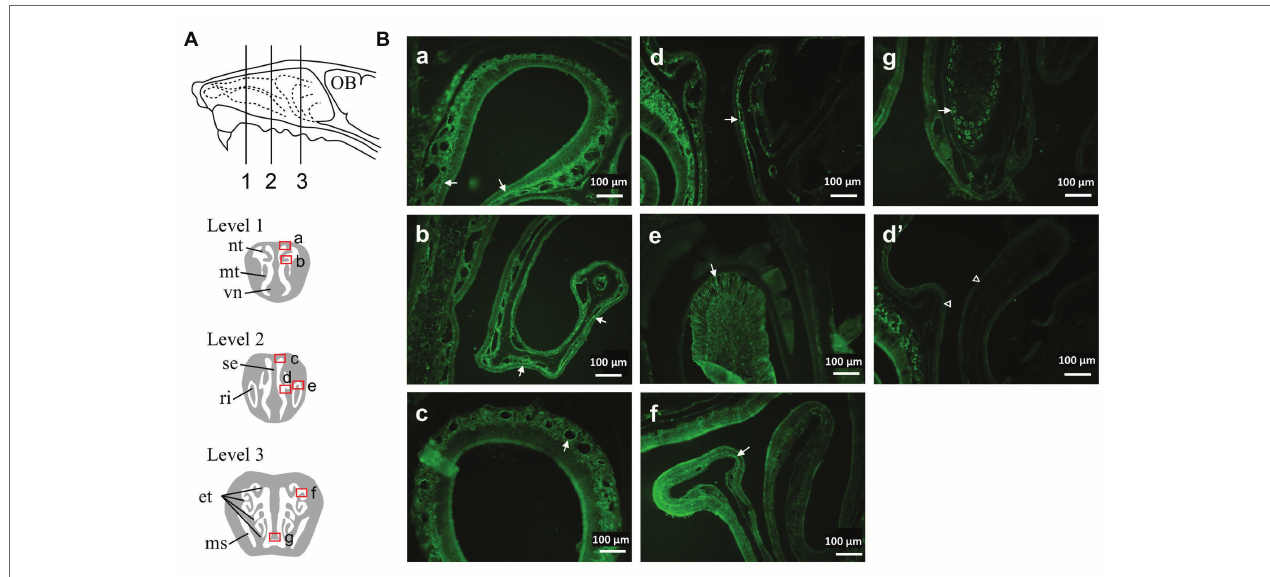
FIGURE 1 | Distribution of Transient receptor potential ankyrin 1 (TRPA1) immunoreactivity in the nasal cavity of mouse. (A) Schematic representation of the lateral view of the mouse nasal area showing three levels of the coronal sections examined. (B) Photomicrographs taken from the areas indicated by squares (a–g) in (A) of a representative mouse. Arrows indicate TRPA1-positive structures (see text). (d’) was taken from a similar region to (d) and treated with a mixture of anti-TRPA1 antibody and an excess amount of antigen peptide. Similar results were obtained in three animals. et, ethmoturbinate; ms, maxillary sinus; mt, maxilloturbinate; nt, nasoturbinate; OB, olfactory bulb; ri, root of incisor tooth; se, septum; vn, vomeronasal